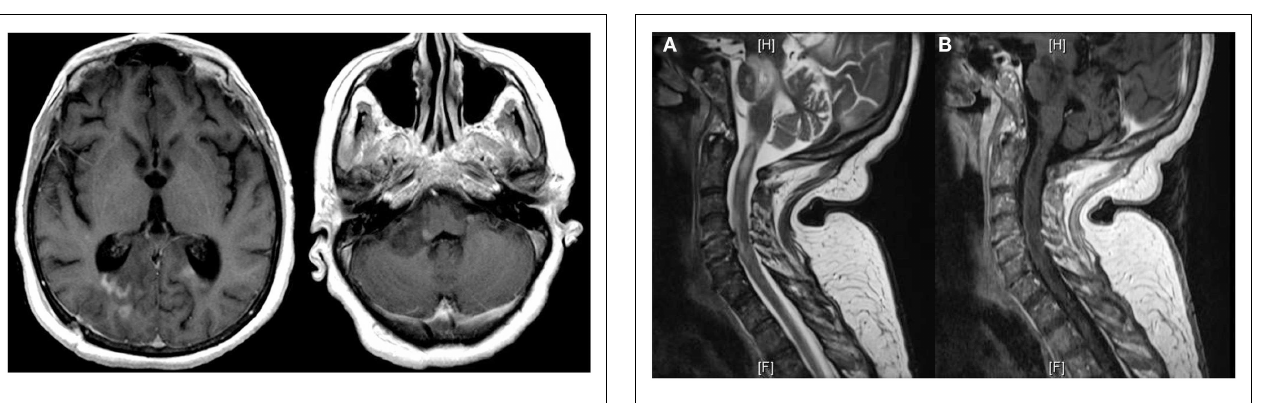
FIGURE 4 |T2W-MRI of the cervical spine shows multiple non-contiguous expansive lesions from the cervico-medullary junction to the level of the sixth cervical vertebra (A). T1W-MRI with contrast demonstrates patchy enhancement (B)